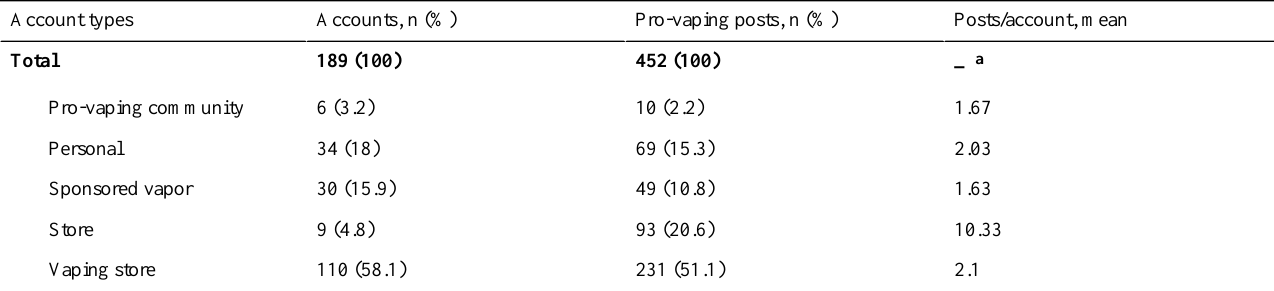
Table 2. Types of pro-vaping Instagram user accounts.